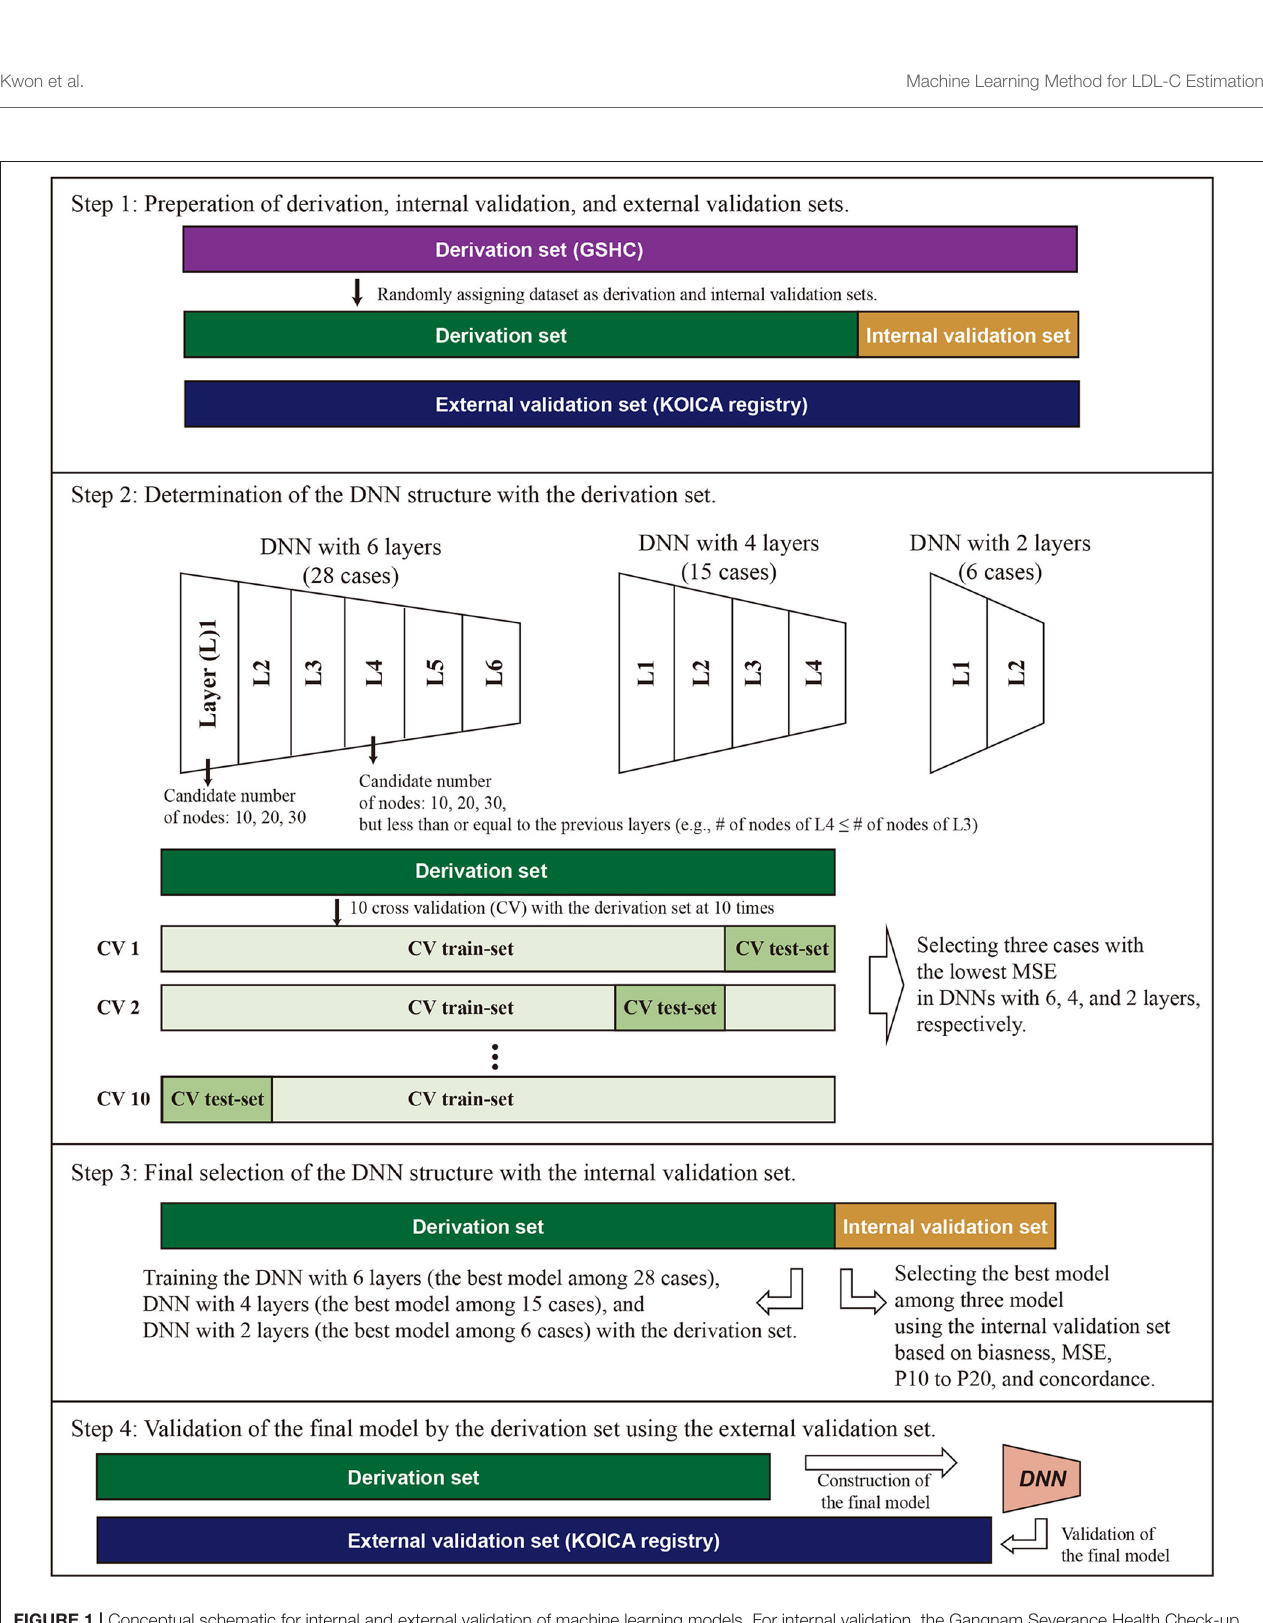
FIGURE 1 | Conceptual schematic for internal and external validation of machine learning models. For internal validation, the Gangnam Severance Health Check-up (GSHC) was reserved for testing the model performance. For external validation, Korean Initiatives on Coronary Artery Calcification (KOICA) registry was used to test the model performance. The DNN consists of six hidden layers, four hidden layers, and two hidden layers, with 30 nodes in each layer. Ten cross-validation was performed to determine the structure of DNN in the derivation set. We selected the best DNN model with lowest mean standard error (MSE) among the three layers. A total of three DNN models were competed. The final model was validated using the external validation set.